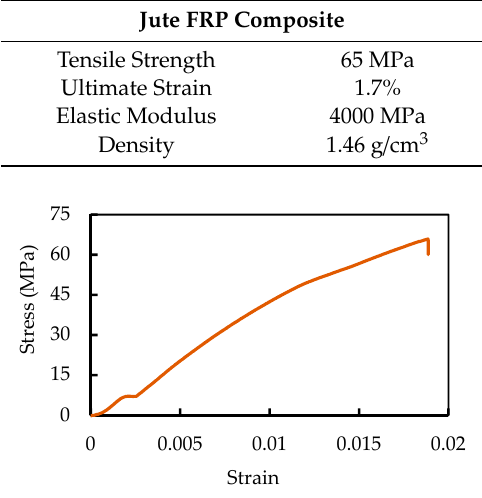
Figure 2. Stress-strain curve of the jute FRP composite.